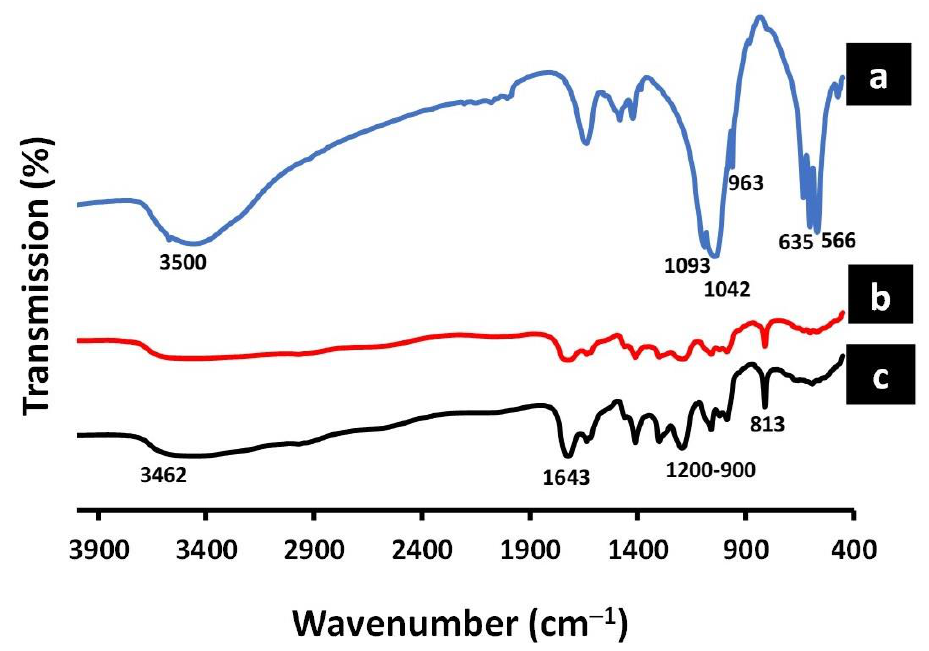
Figure 6. The FTIR spectrums of ( a ) nanohydroxyapatite (nHA), ( b ) 25% GA/chitosan/5% nHA hydrogel, and ( c ) 25% GA/chitosan/0% nHA hydrogel .